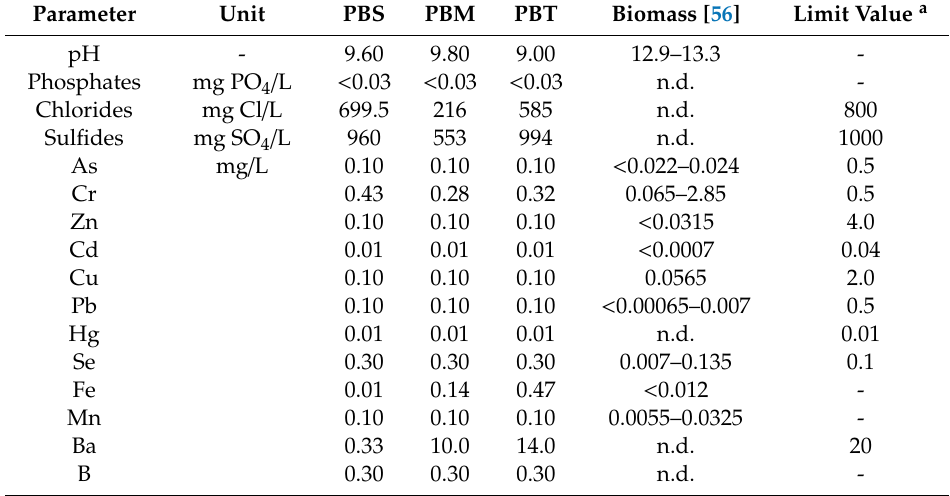
Table 6. Analysis of water extracts from the residues after combustion of sewage sludge fuels and